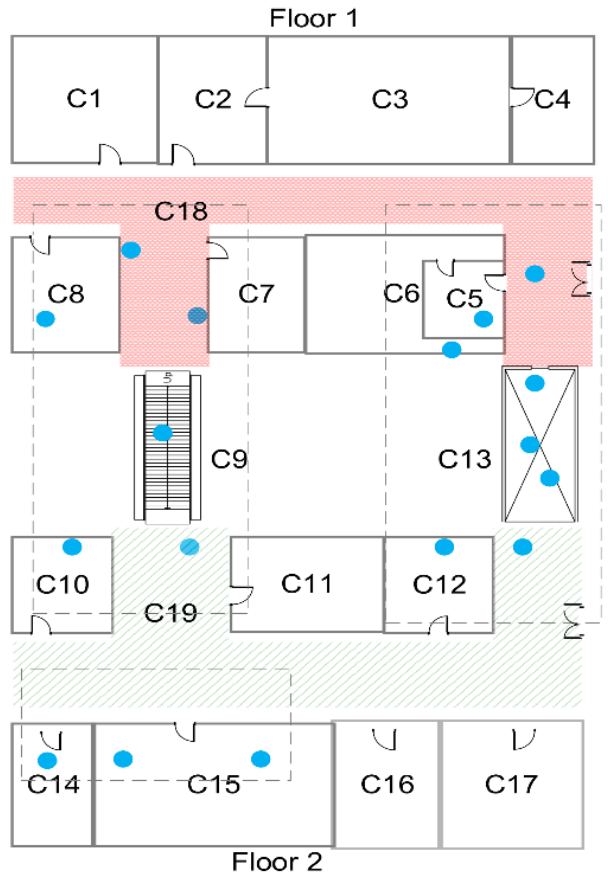
Table 4. The adjacency distance table.